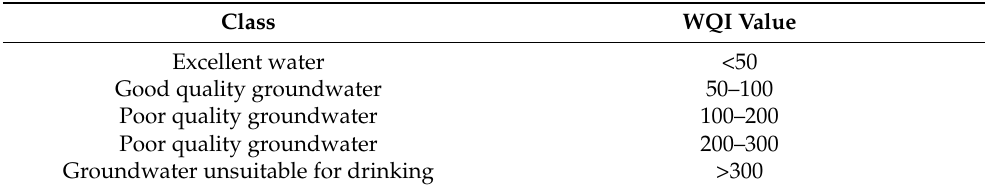
Table 4. Categories of the water quality